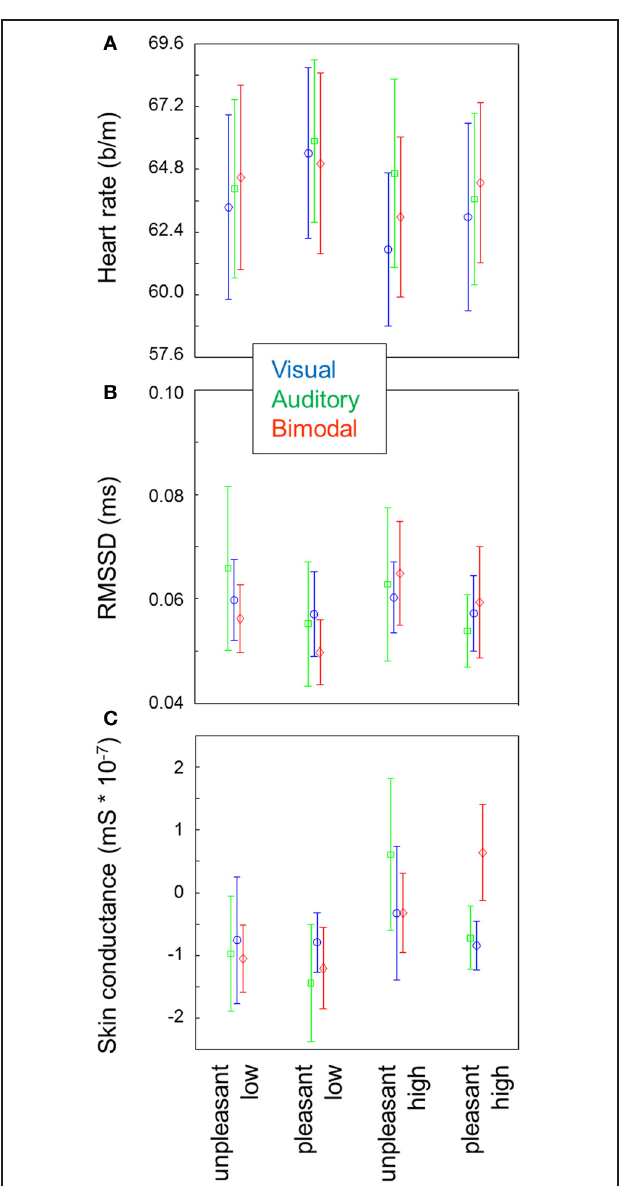
FIGURE 1 | Heart rate (A), RMSSD, (B) and skin conductance (C) for each of the conditions. Error bars represent standard errors of the mean between participants. For heart rate, a repeated measure ANOVA indicates main effects of arousal and valence. For heart rate variability and skin conductance, repeated measures ANOVAs indicate main effects of